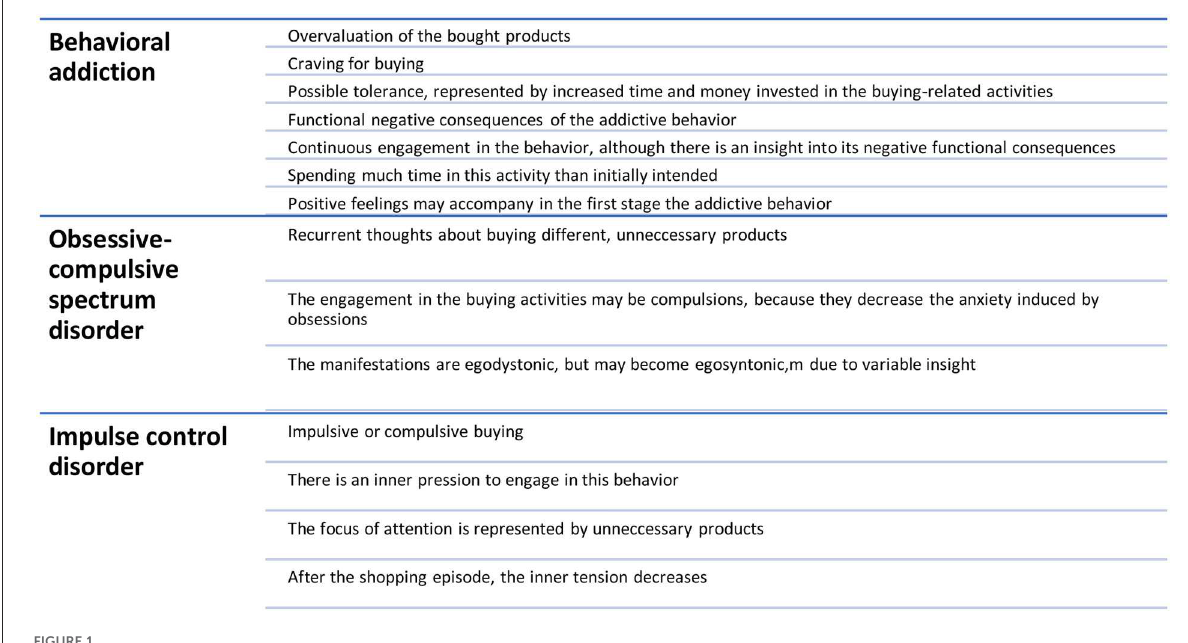
FIGURE1 Compulsive shopping disorder—clinical